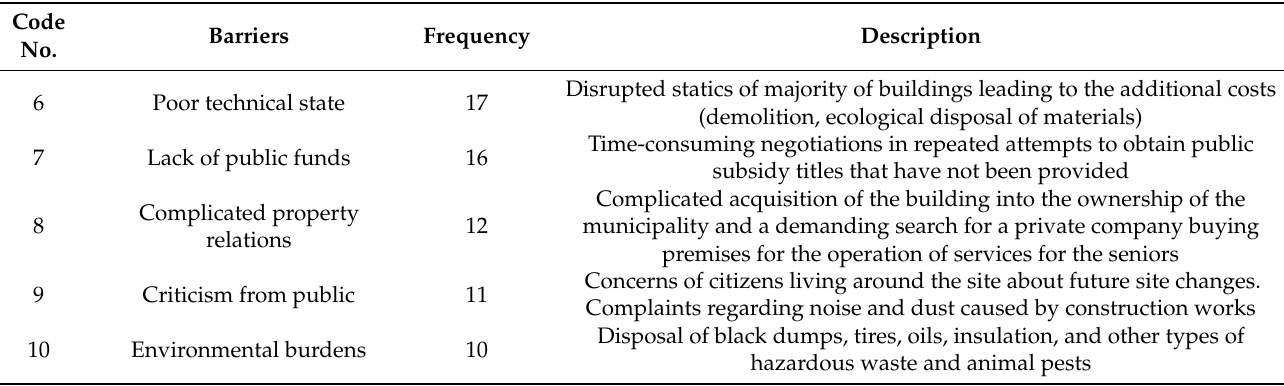
Table 4. Information about the main identified barriers of the redevelopment process related to the case study area.